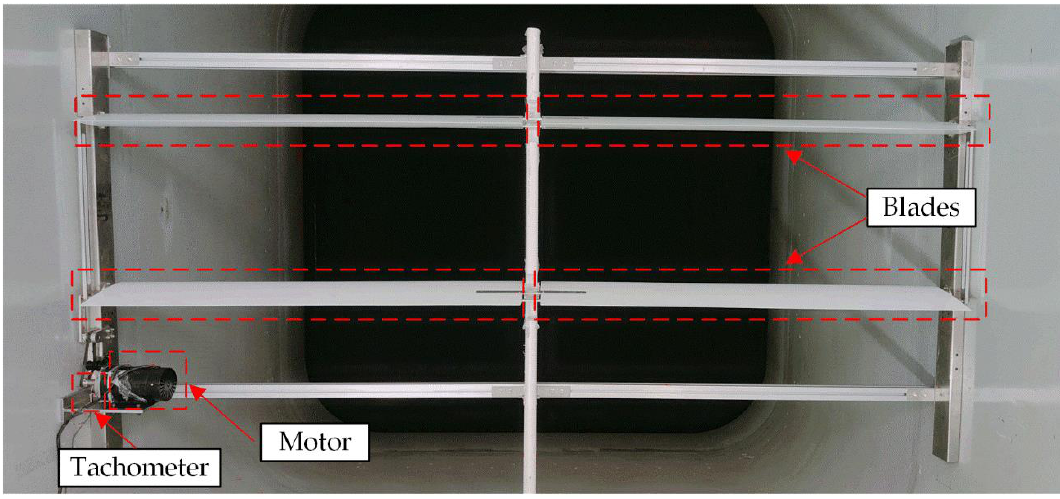
Figure 4. Gust generator.